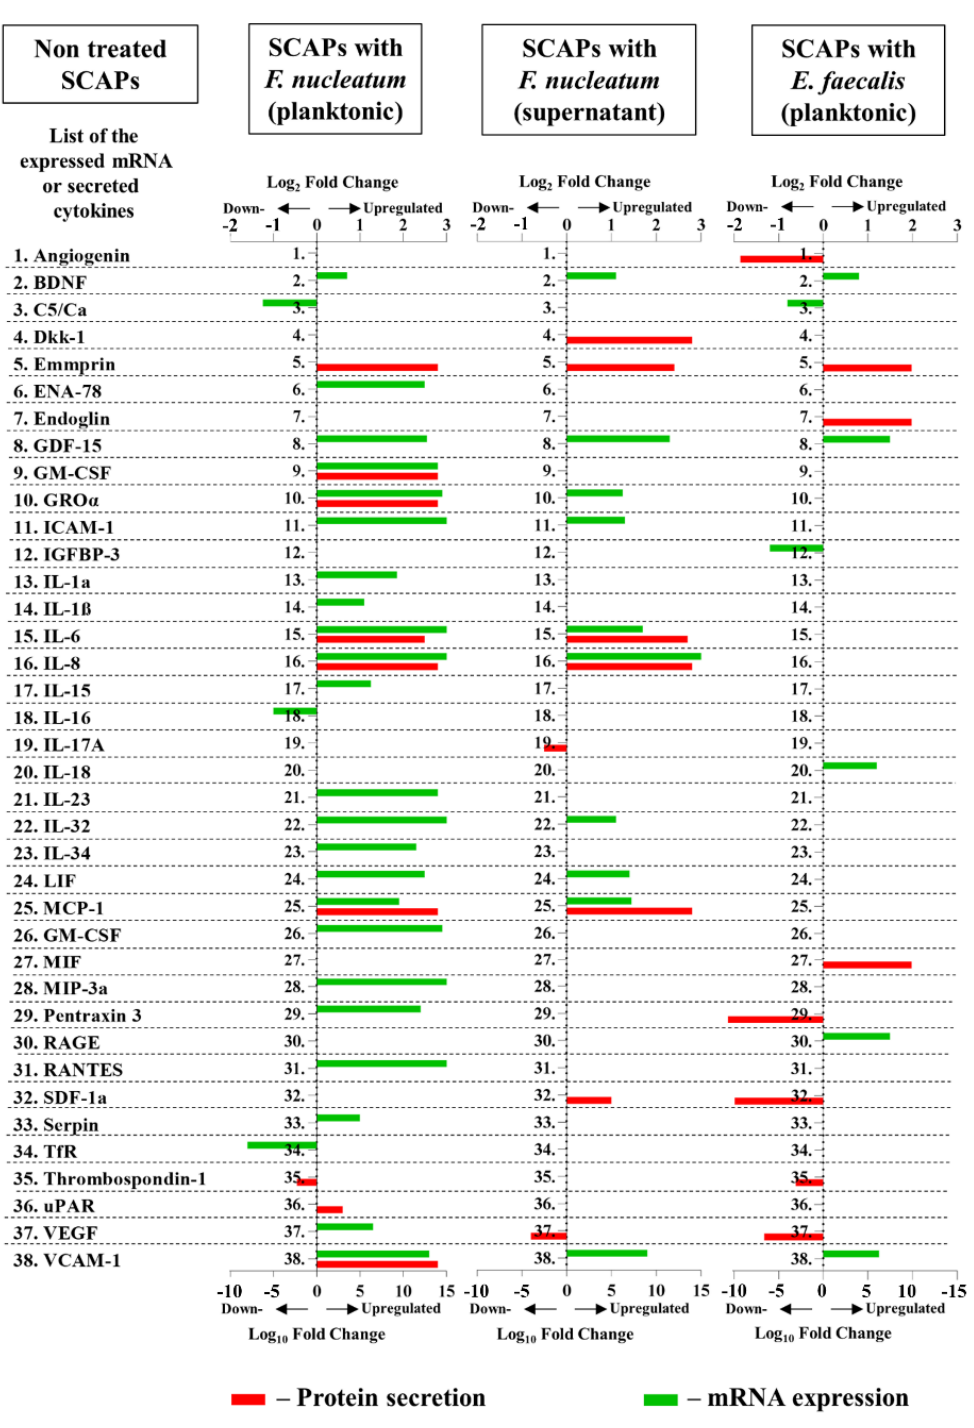
Figure 4. Up- and downregulation of the cytokines by SCAP with different variants of treatment detected at mRNA and protein levels. The regulation of protein secretion is expressed in log 10 fold change, and the corresponding mRNA expression is expressed in log 2 fold change. mRNA level, while only twelve had detectable upregulation at the protein level (Figure